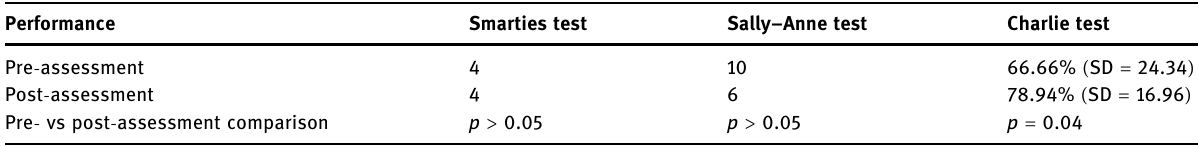
Table 2: Children ’ s pre - and post - assessment performance. Results of the Smarties and the Sally – Anne tests are presented in the number of children who passed each time ( pre - and post - intervention ) , while results of the Charlie test are presented in the mean percentage of participants ’ performance over the 15 trials of the